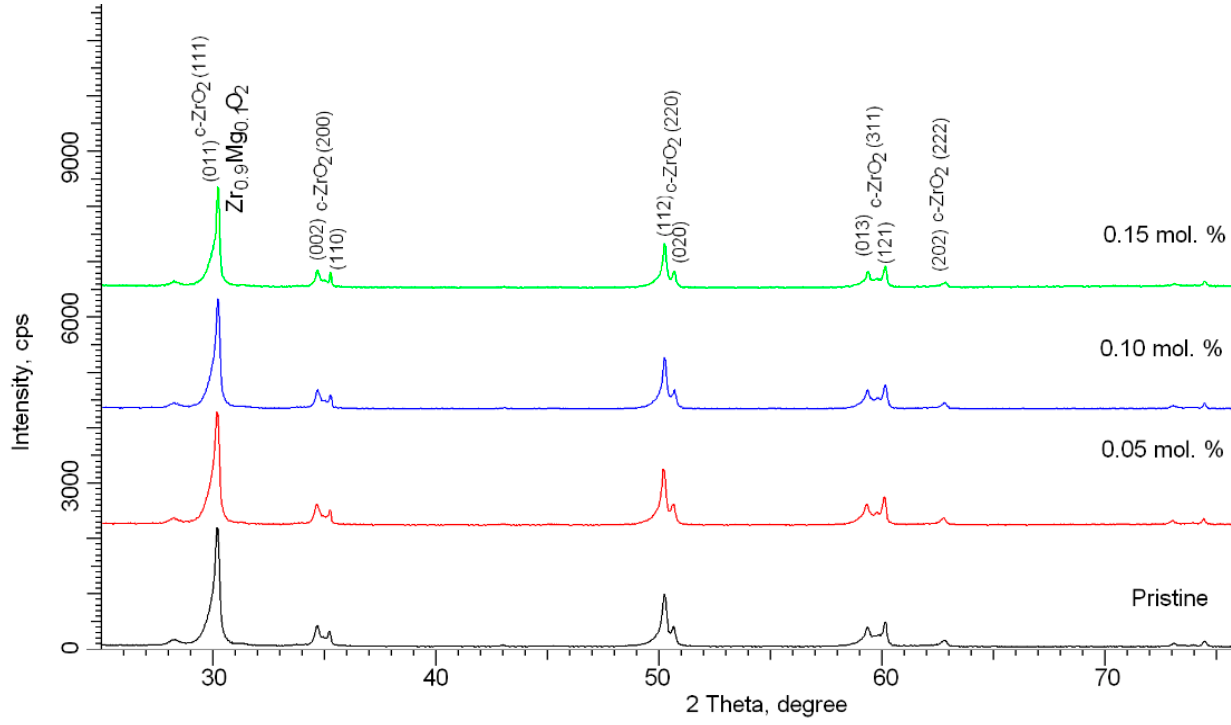
Nanomaterials 2021 , 11 , x FOR PEER REVIEW Figure 1. X-ray diffraction patterns of the studied samples of ceramics depending on the concentration of the MgO dopant.